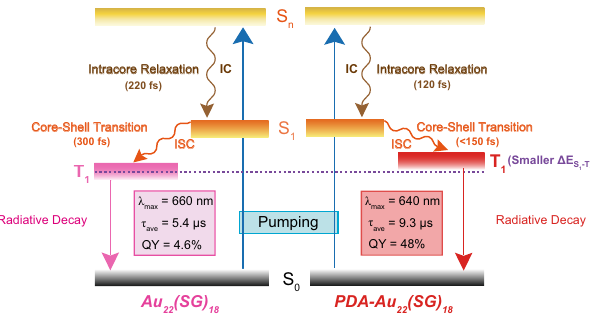
Fig. 5 Schematic diagram illustrating the excited-state dynamics of Au 22 (SG) 18 and PDA-Au 22 (SG) 18 NCs. Arrows denote the transitions between different electronic states. S 0 ground state, S n high singlet state, S 1 lowest singlet state, T 1 lowest triplet state, IC internal conversion, ISC intersystem crossing, 4 E S energy gap between S 1 and T 1 states, λ max 1 (cid:2) T 1 maximum emission wavelength, τ ave average luminescence lifetime, QY luminescence quantum